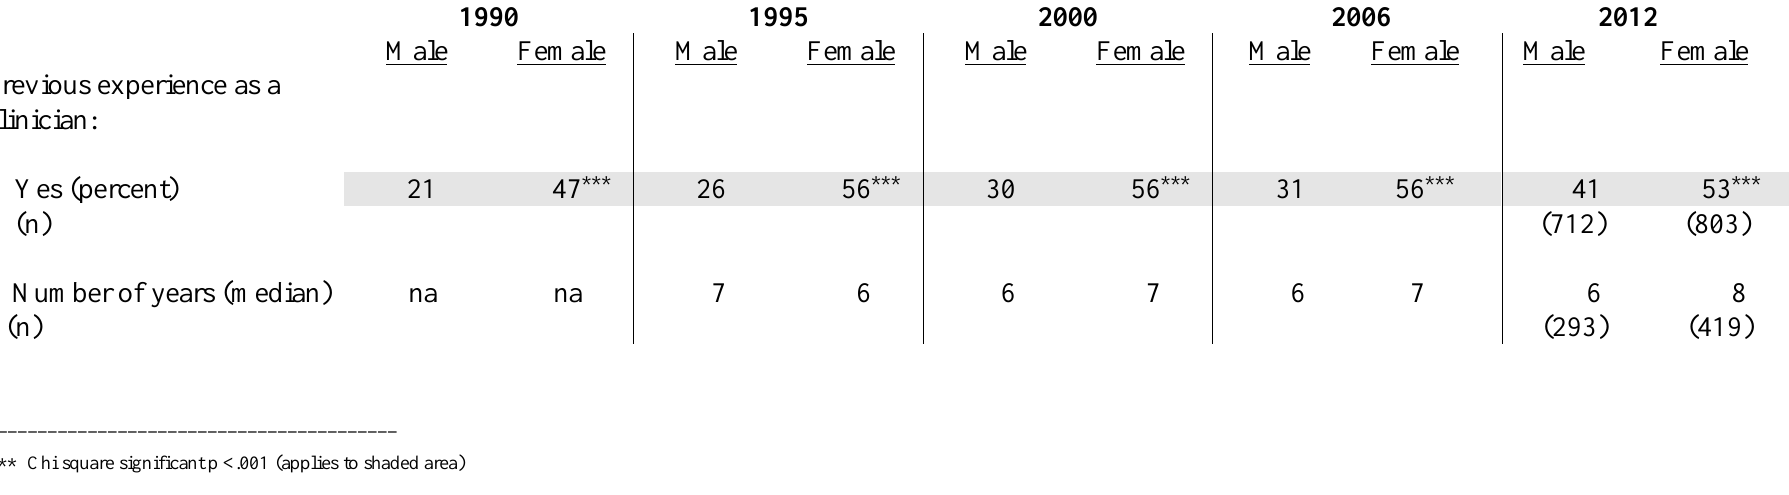
Table 14. Career